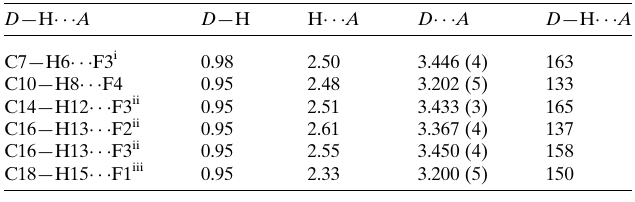
Table 2 Experimental details.